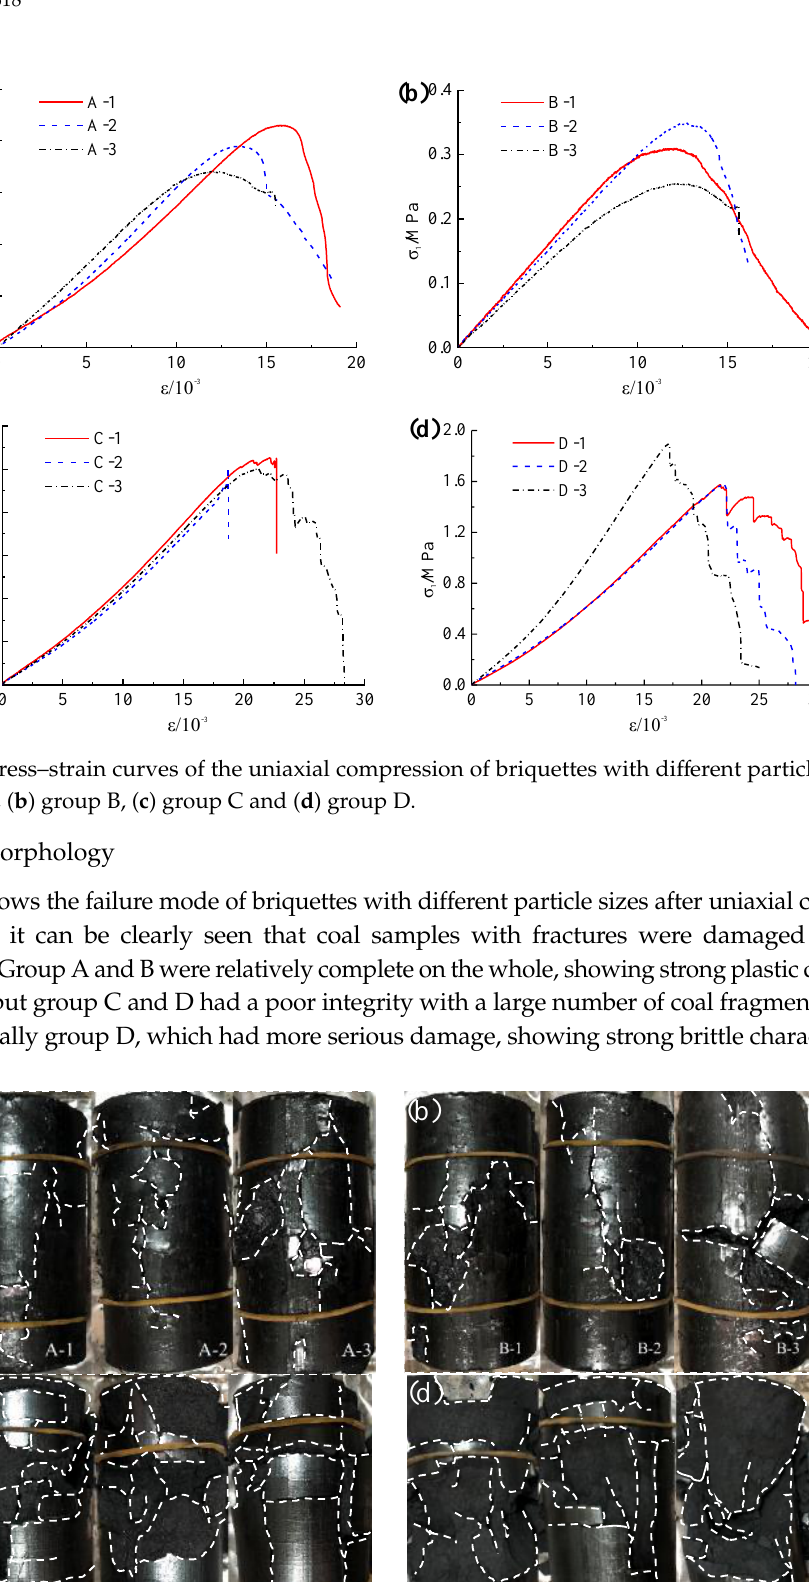
Figure 6. Uniaxial compression failure morphology of briquettes with different particle sizes: ( a ) group A, ( b ) group B, ( c ) group C and ( d ) group D.